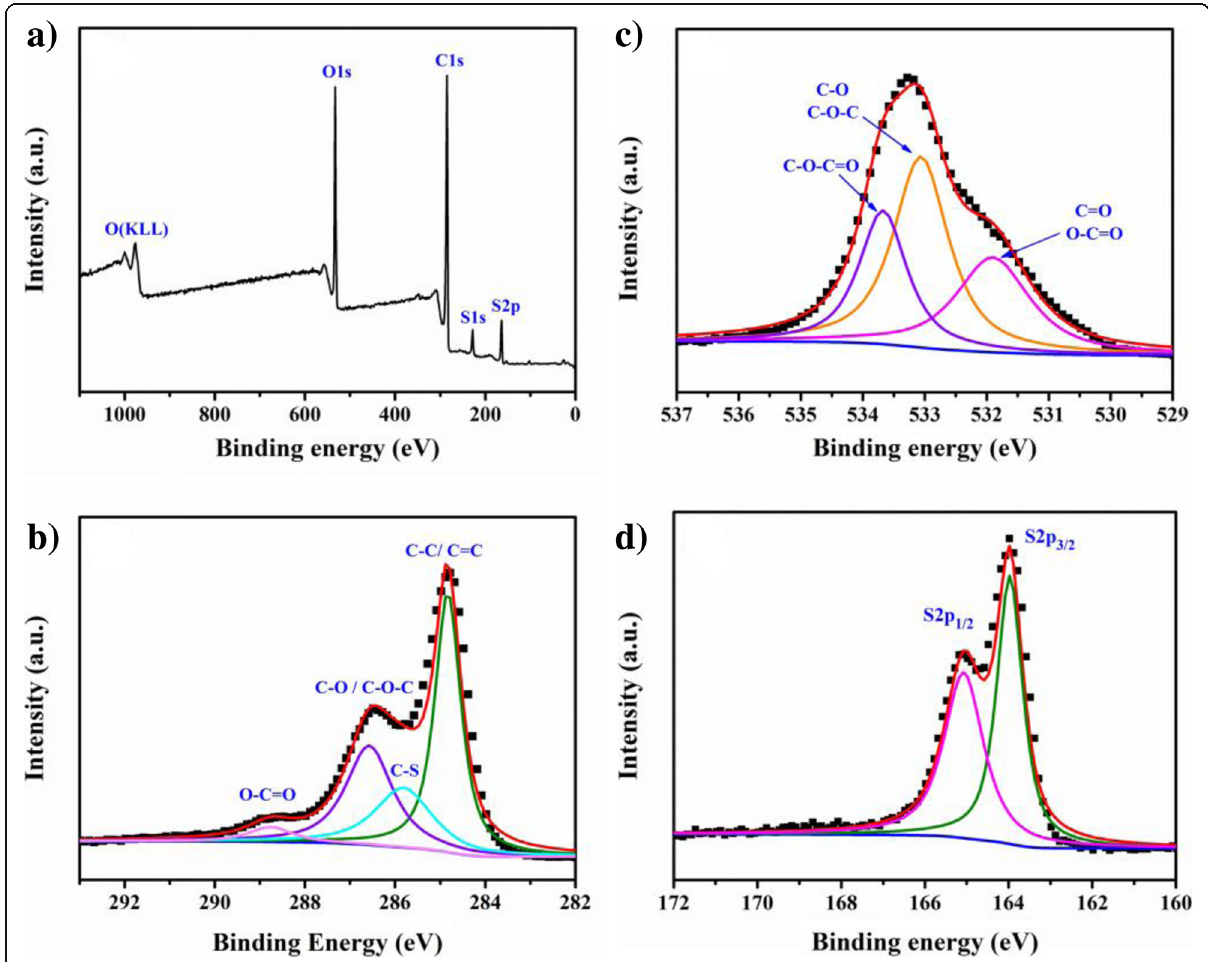
Fig. 4 XPS spectra of rGO/PEDOT. a Full spectra. b C 1s . c O 1s . d S